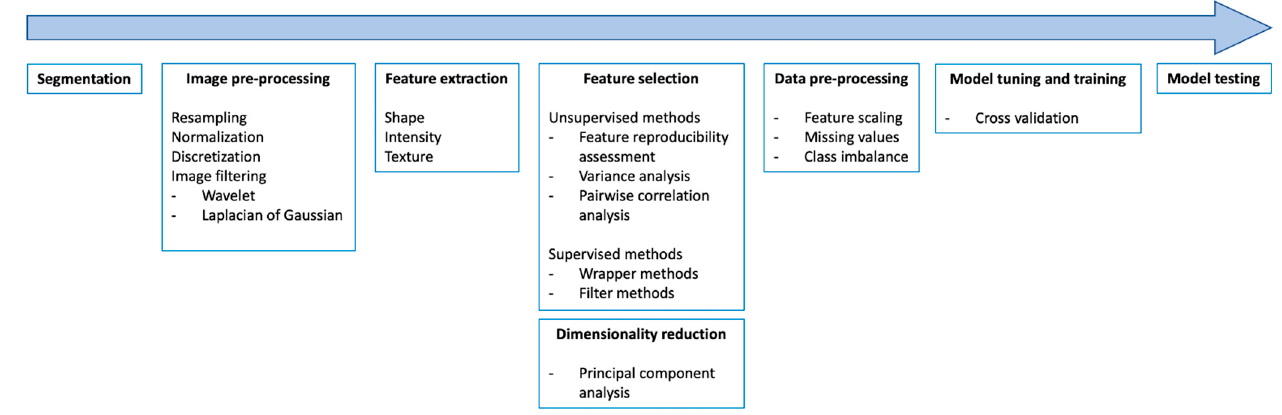
Figure 1. The main steps of a radiomic